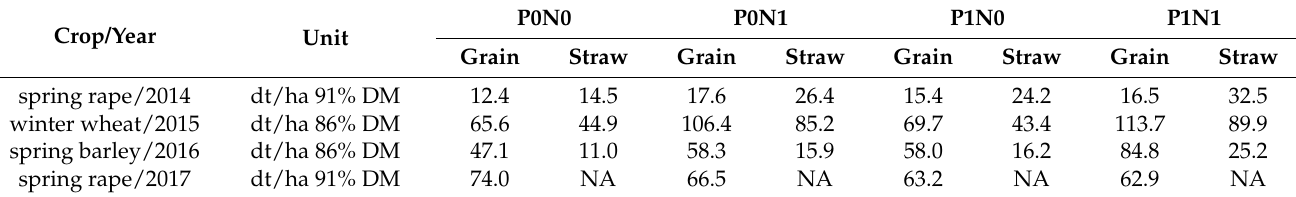
Table 5. The yield of crops grown under different managements in